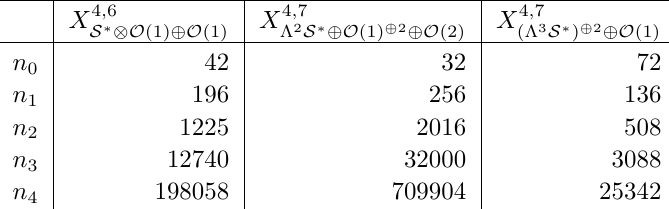
Table 5 . The triple intersection number and instanton numbers for CY 3-folds in Gr(4 ; m ).